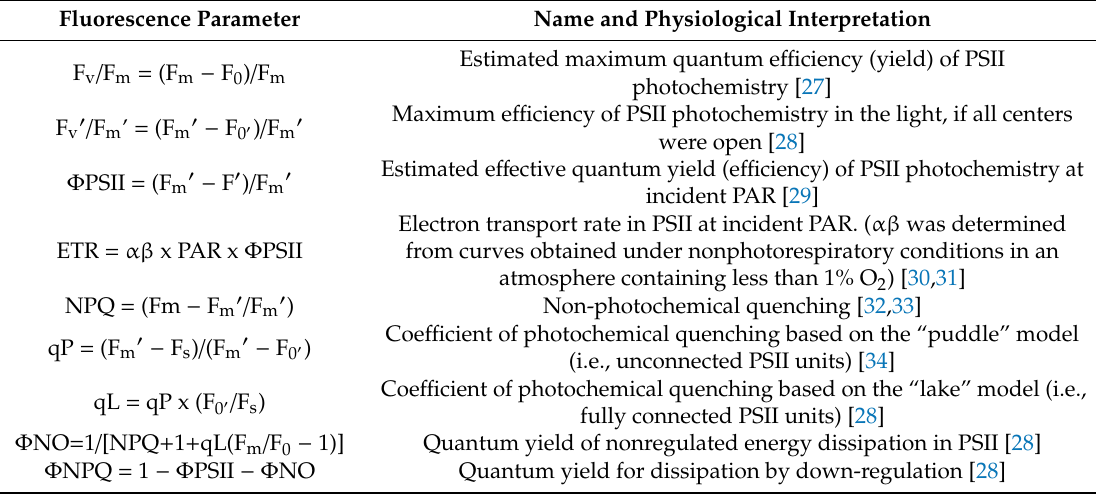
Table 3. Fluorescence parameters calculated from saturating pulse analysis. Fluorescence